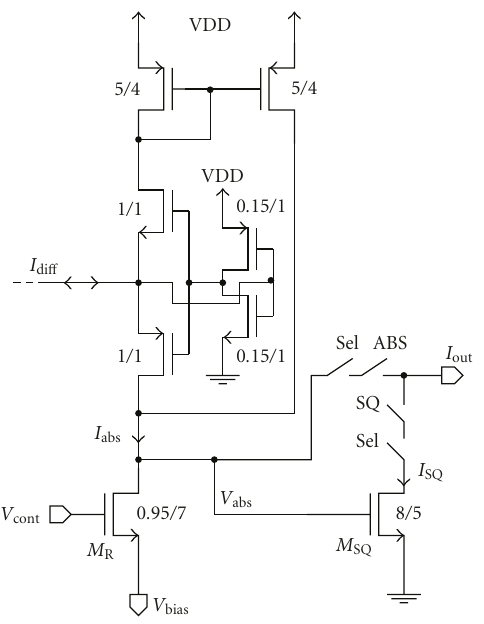
Figure 6: Absolute value and quadrature circuitry. The applied transistor dimensions ( W/L ) are in micrometers.